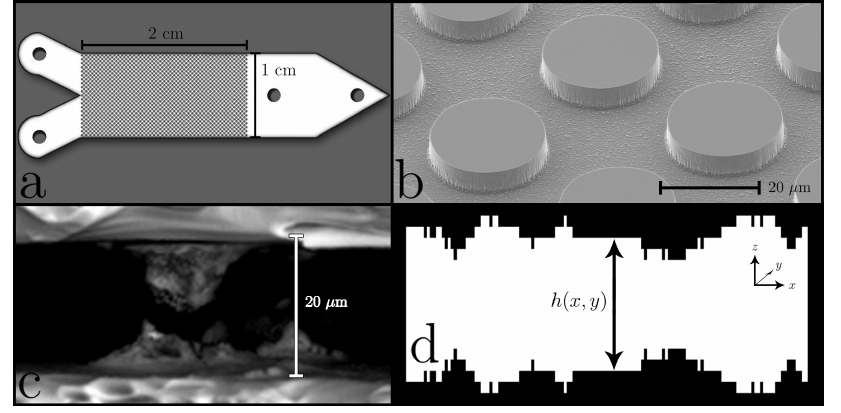
( a ) Entire micromodel with a regular pore network of cylindrical pillars; ( b ) Perspective view of micromodel interior taken with scanning electron